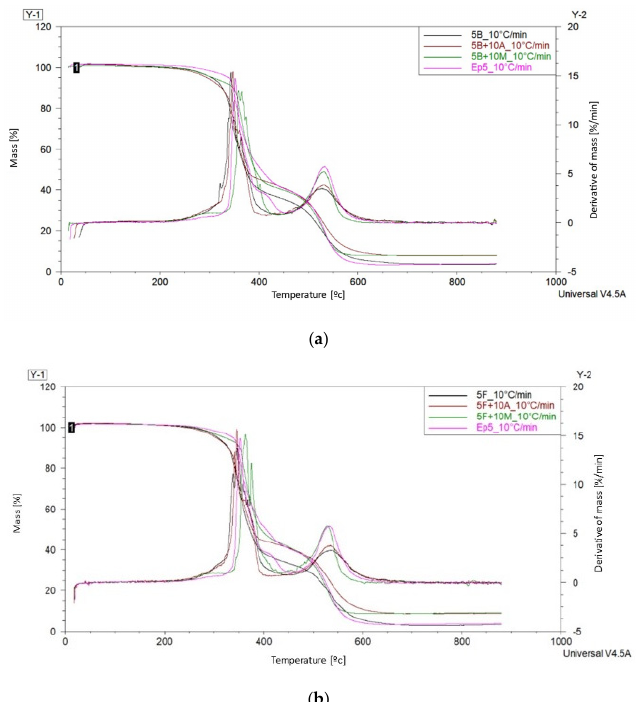
Figure 2. TG and DTG curves obtained from the thermal decomposition of samples modified with: ( a ) Roflam B7 and hydroxides and ( b ) Roflam F5 and hydroxides, at a heating rate of 10 °C/min. The values of the initial temperature of thermal decomposition in phase I of epoxy resin samples modified with magnesium hydroxide (sample 5M) or 5 wt.% organophos ‐ phorus compound and 10 wt.% magnesium hydroxide (samples 5B + 10M and 5F + 10M) were found to be higher as compared to unmodified epoxy resin for these samples (e.g. , at a heating rate of 10 °C/min by 12 °C–5M). The temperatures of the maximum rate of sample weight loss during phase 1 of the transformation were found to be the highest for sample 5B + 10M, with a difference of 32 °C. The lowest temperature of onset of thermal decomposition was recorded for sample 10B + 5A. 3.3. Results of Studies on Mechanisms of Flame Retardant In order to clarify the flame retardant effect of aluminium and magnesium hydrox ‐ ides on epoxy resin, scanning electron microscopy studies fitted with an EDS spectrometer attachment were carried out. The fractures of samples of modified and unmodified Ep ‐ idian 5 epoxy resin before combustion were analysed both qualitatively and quantita ‐ tively. An analogous analysis was then carried out for the chars of the samples, which were obtained by placing these samples in a smoke chamber for 2 min at a thermal expo ‐ sure of 50 kW/m 2 .